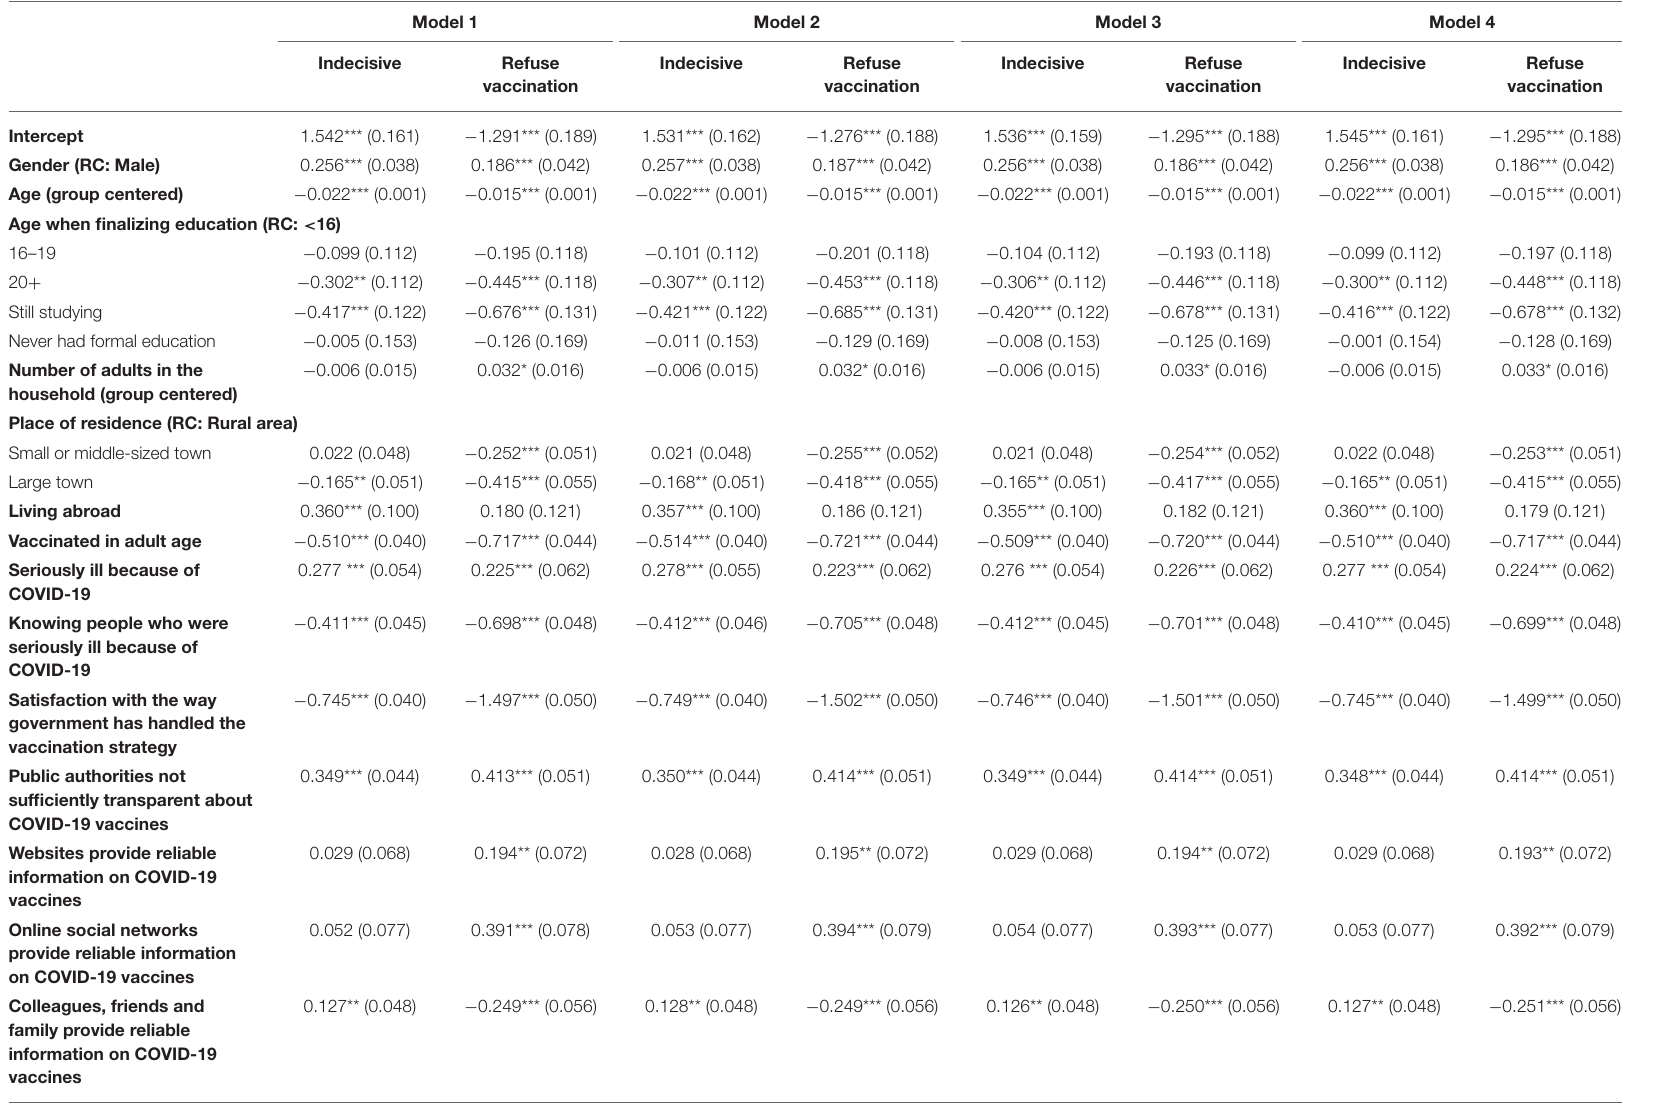
TABLE 1 | Results of the multilevel multinomial